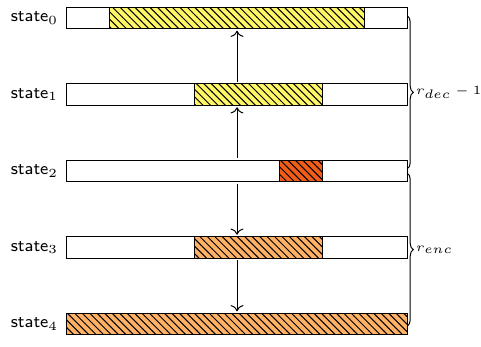
Figure 2: Building an integral